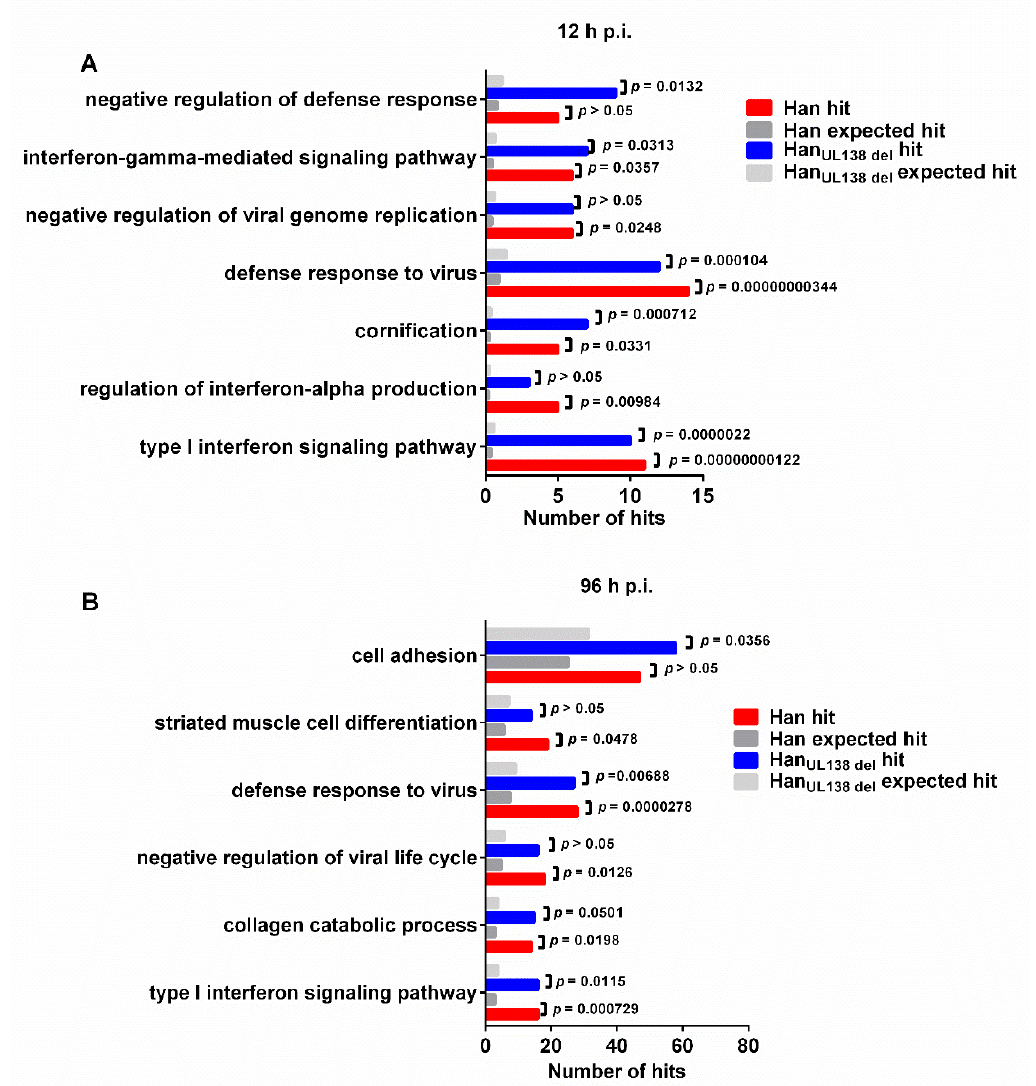
Figure 3. Gene Ontology analysis (biological process) of di ff erentially regulated proteins at 12 h p.i. or 96 h p.i.. Di ff erentially regulated proteins at 12 h p.i. ( A ) or 96 h p.i. ( B ) were subjected to DAVID v6.8. The regulated proteins were grouped based on their roles in biological processes, and a statistical overrepresentation test was performed to determine which biological process was overrepresented by di ff erentially regulated proteins. Only the overrepresented categories are presented here. Expected hits indicate the presumed number of hits in this